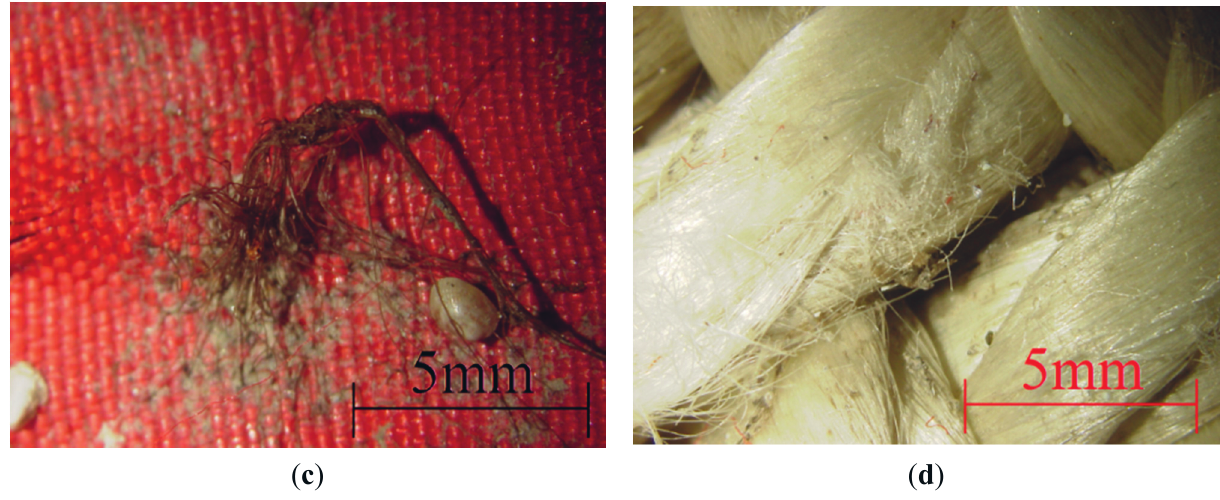
Figure 16. ( a ) Crushed mussel growth; ( b ) byssal filaments on inner surface of rope; ( c ) byssal filaments on the anti-friction membrane; and ( d ) evidence of wear of rope yarns.